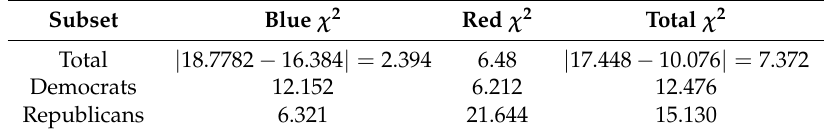
Table 6. The deviation of χ 2 of G(t) , D(t) , and R(t) from their respective expected χ 2 values.